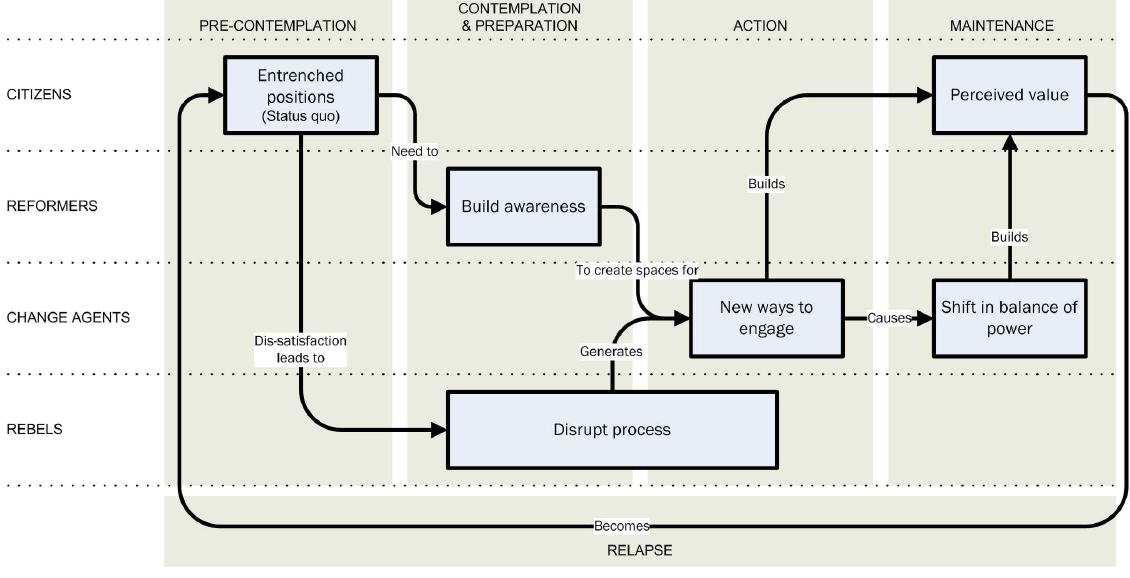
FIGURE 1: EMERGENT EDEMOCRACY